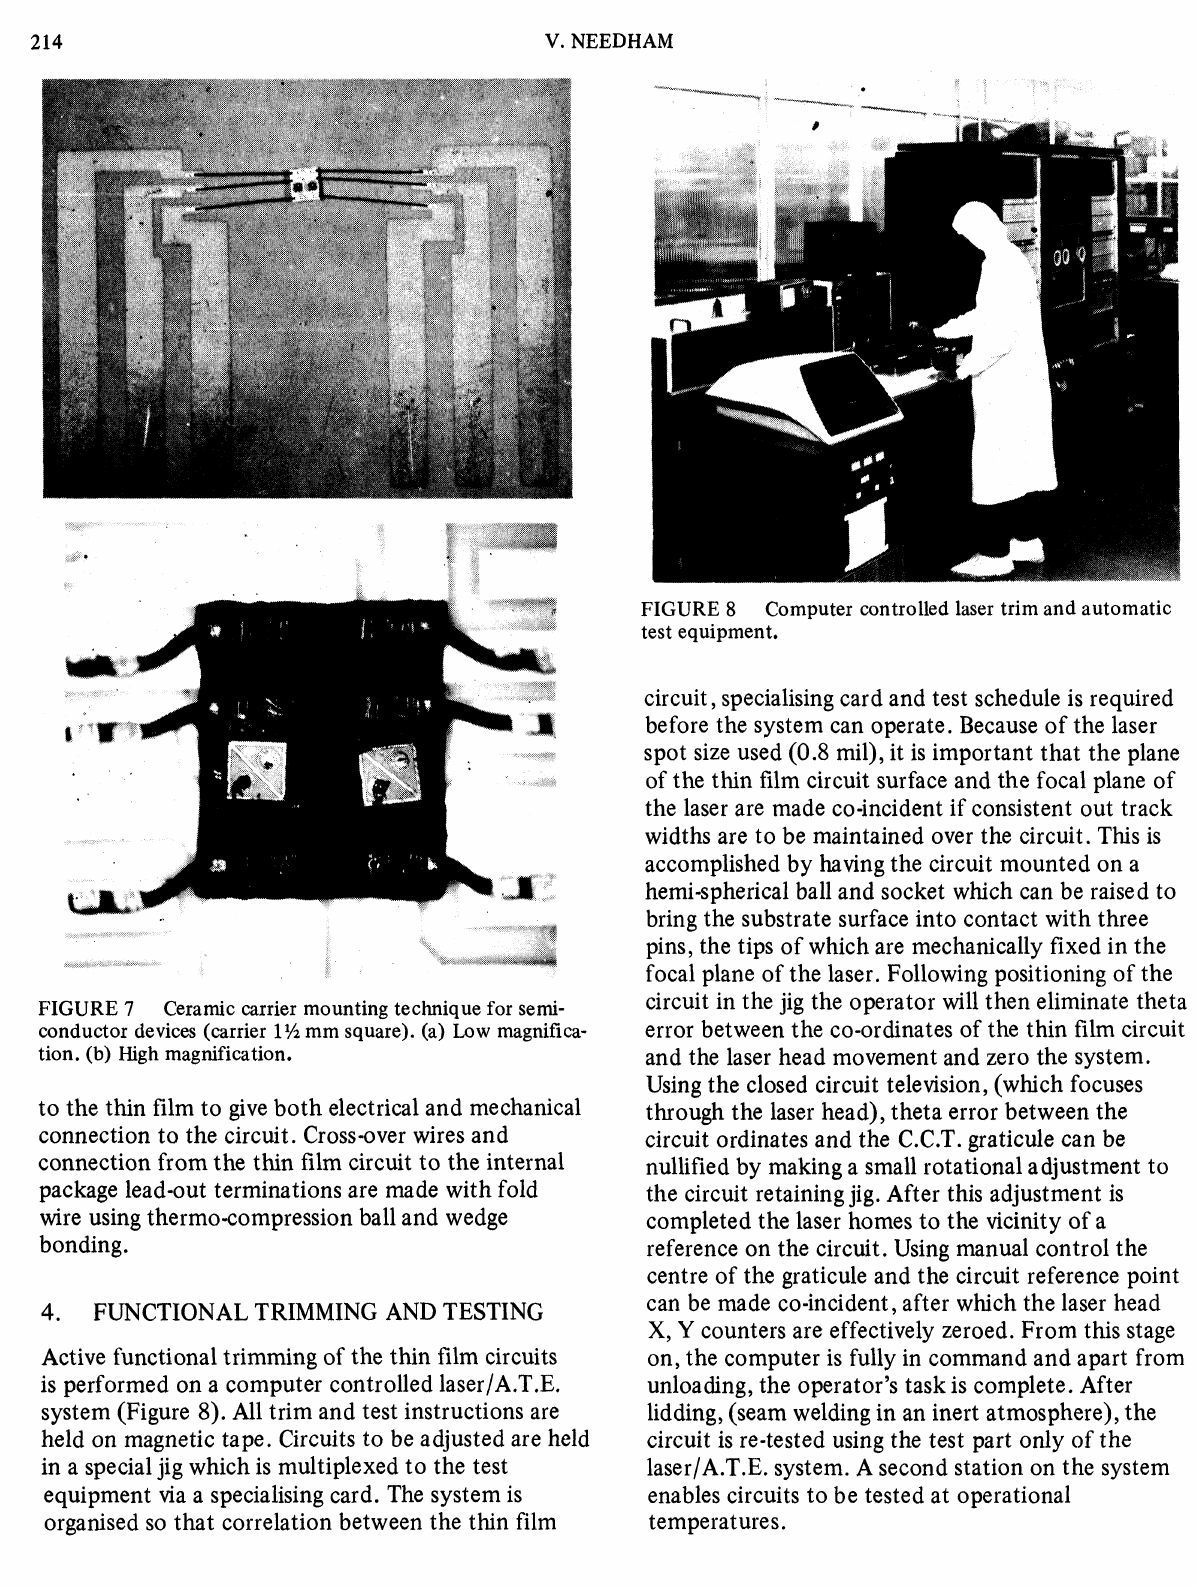
FIGURE 7 Ceramic carrier mounting technique for semi- conductor devices (carrier 11A mm square). (a) Low magnifica- tion. (b) High magnification.